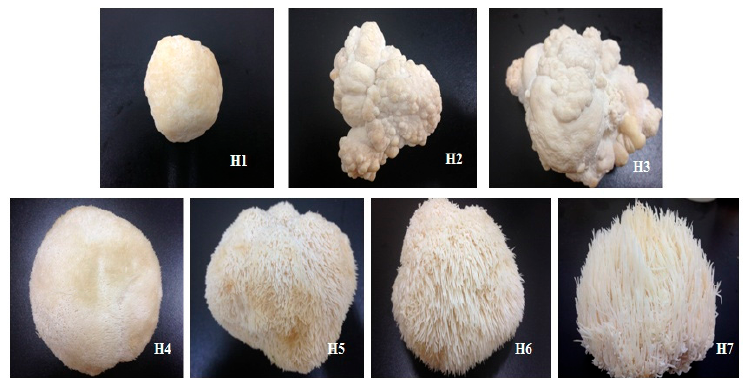
Figure 1. Morphologies of Hericium erinaceus fruiting bodies at seven growth stages (H1: